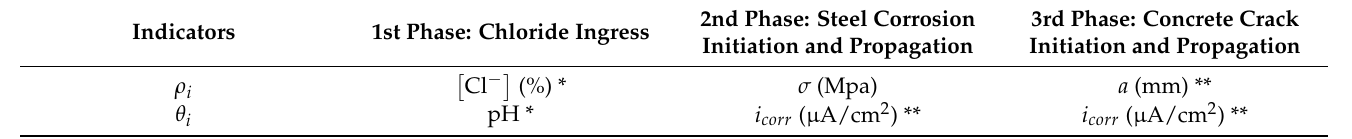
Table 1. Choice of indicators for the three phases of chloride-induced corrosion. 2nd Phase: Steel Corrosion 3rd Phase: Concrete Crack Indicators 1st Phase: Chloride Ingress Initiation and Propagation Initiation and